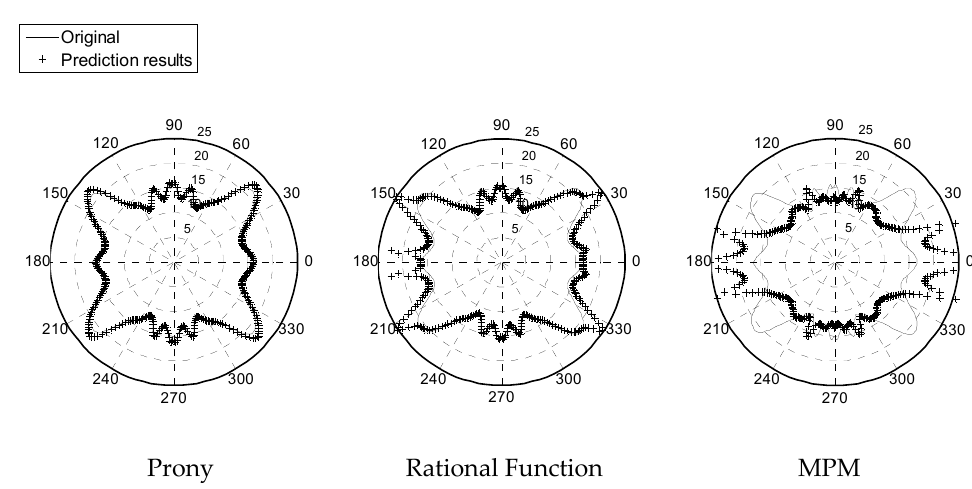
Figure 14. F-117 Prediction results in all directions at 7 GHz.